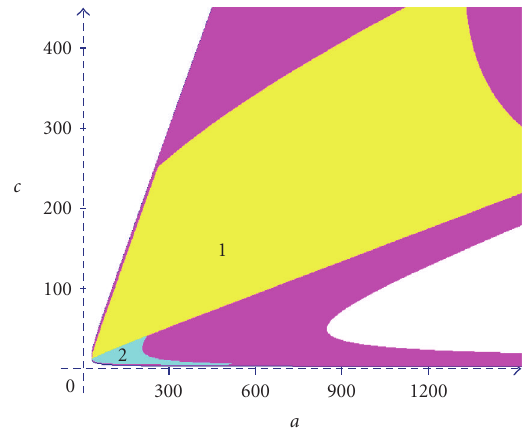
Figure 5.1 . Region of su ffi cient stability condition for (5.2): p = 12, h = 0 . 024, Δ = 0 .